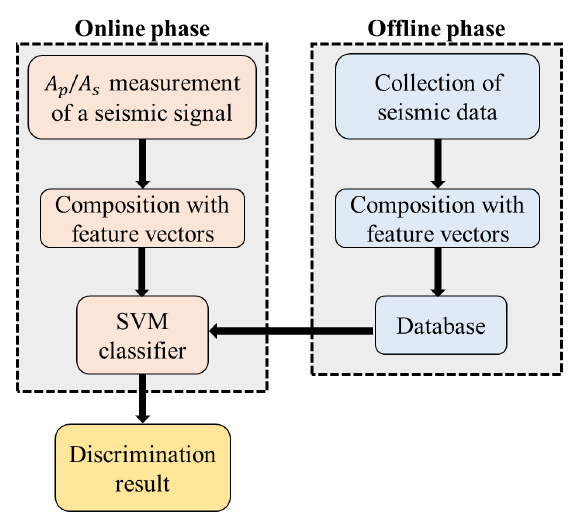
Figure 3. Framework of seismic discrimination